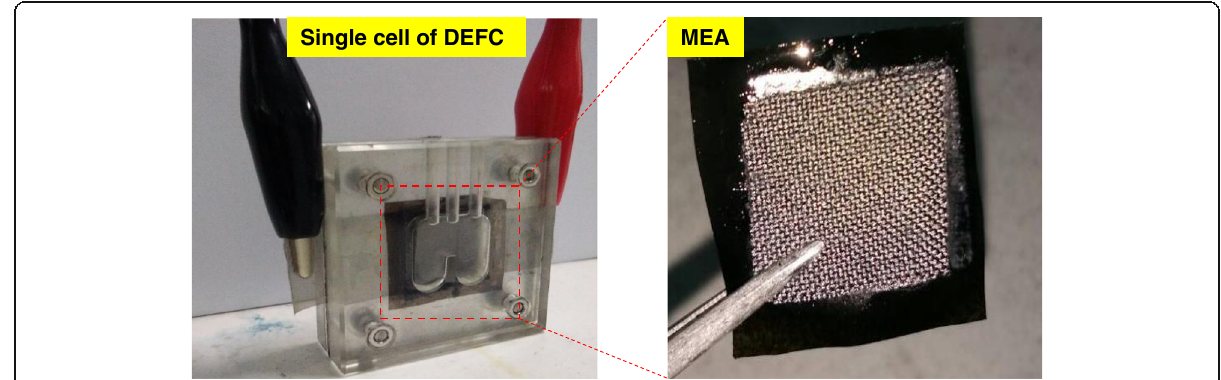
Fig. 2 The single cell of passive alkaline – DEFC and MEA